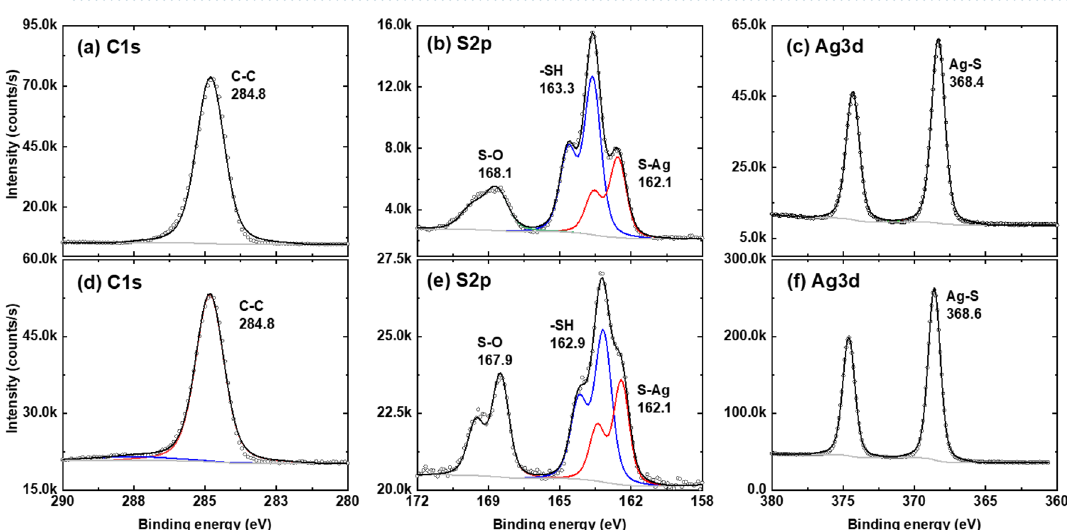
Figure 8. XPS chemical analysis. C1s ( a , d ), S2p ( b , e ) and Ag3d ( c , f ) core level XPS spectra of the 3D printed structures using n-hexane ( a – c ) ethanol ( d – f